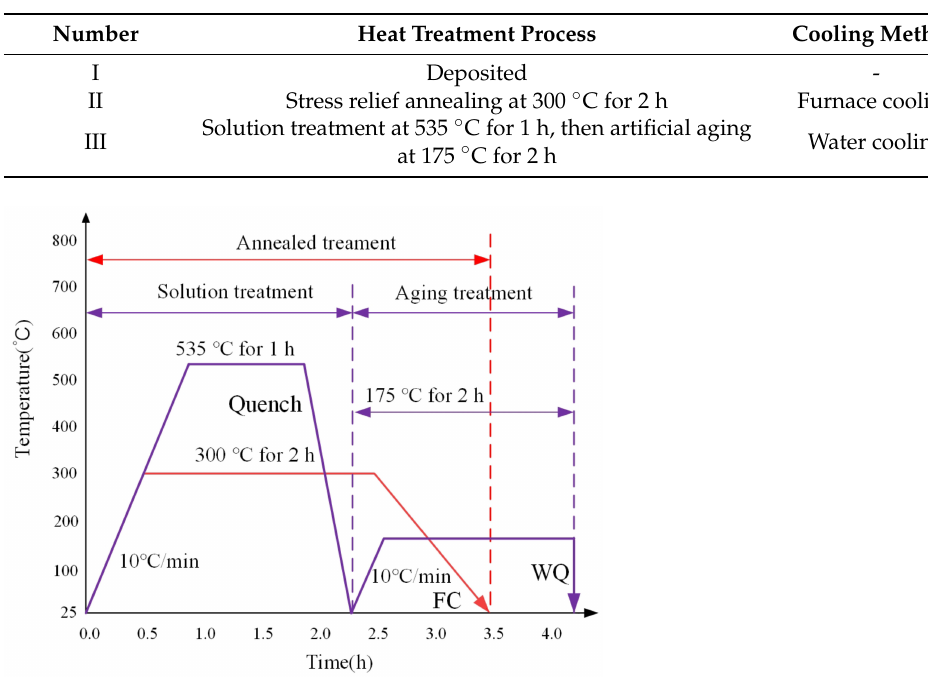
Table 2. The processes of heat treating SLM 6061 aluminum alloy.